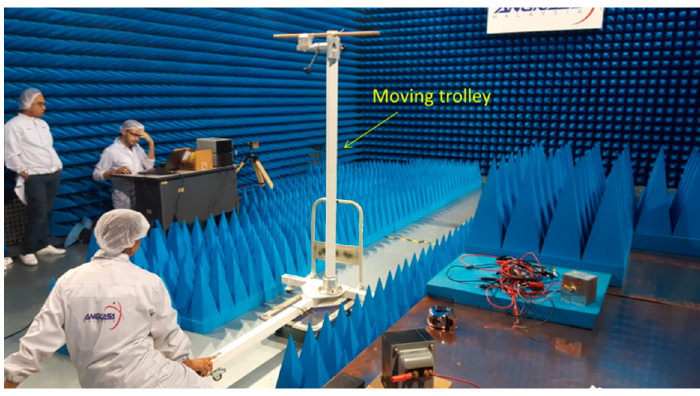
Figure 13. Moving trolley (without any micro motion) crossing the FSR baseline.